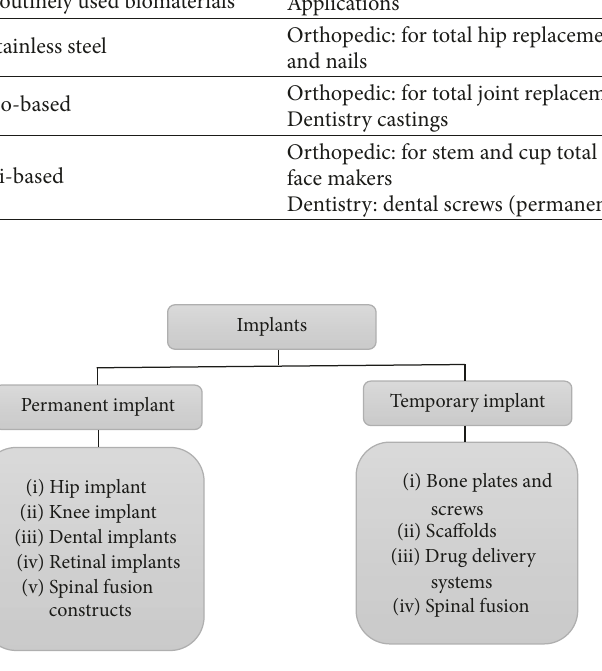
Figure 3: Classification of biomedical